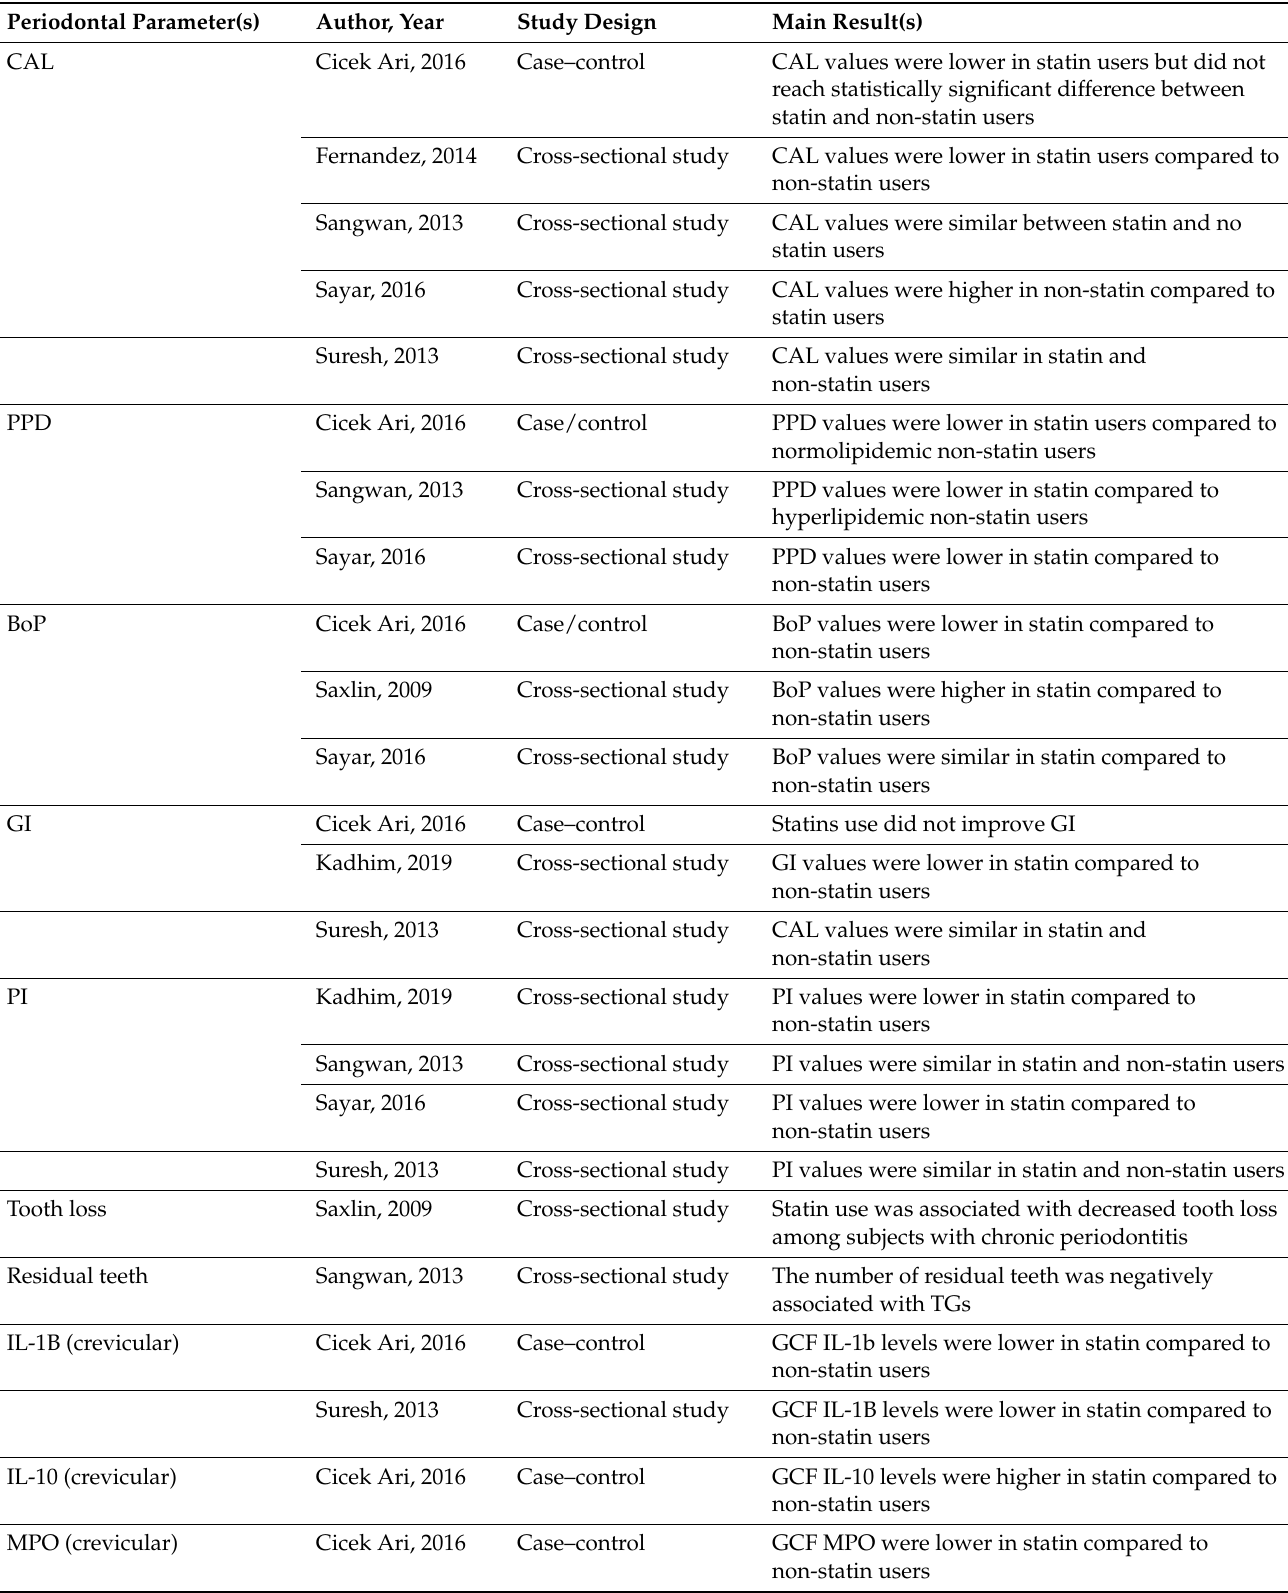
Table 4. Synthesis of the outcomes